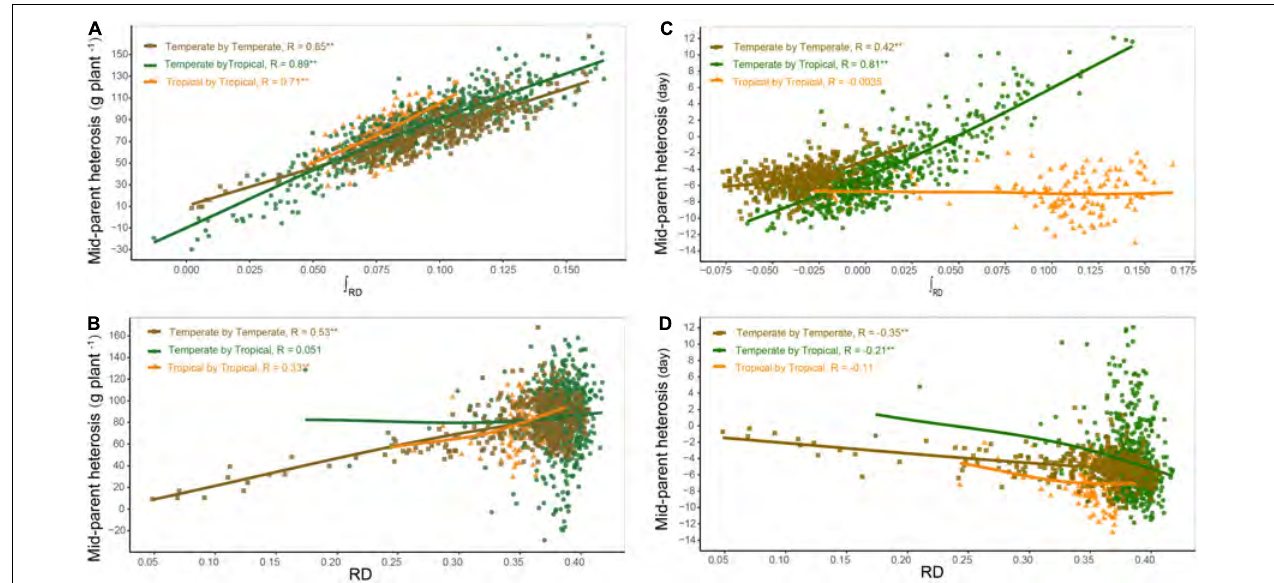
FIGURE 3 | Relationship between genetic distance and heterosis. Panels (A,B) show the relationship of mid-parent heterosis (MPH) with heterotic genetic distance ( ∫ RD ) and Rogers’ distance (RD) for grain yield per plant (GWPP), respectively. Panels (C,D) show the relationship of MPH with ∫ RD and RD for days to silking (DTS), respectively. The regression lines in different colors represent the locally weighted regressions for temperate by temperate (golden), temperate by tropical (green), and tropical by tropical (orange) hybrid